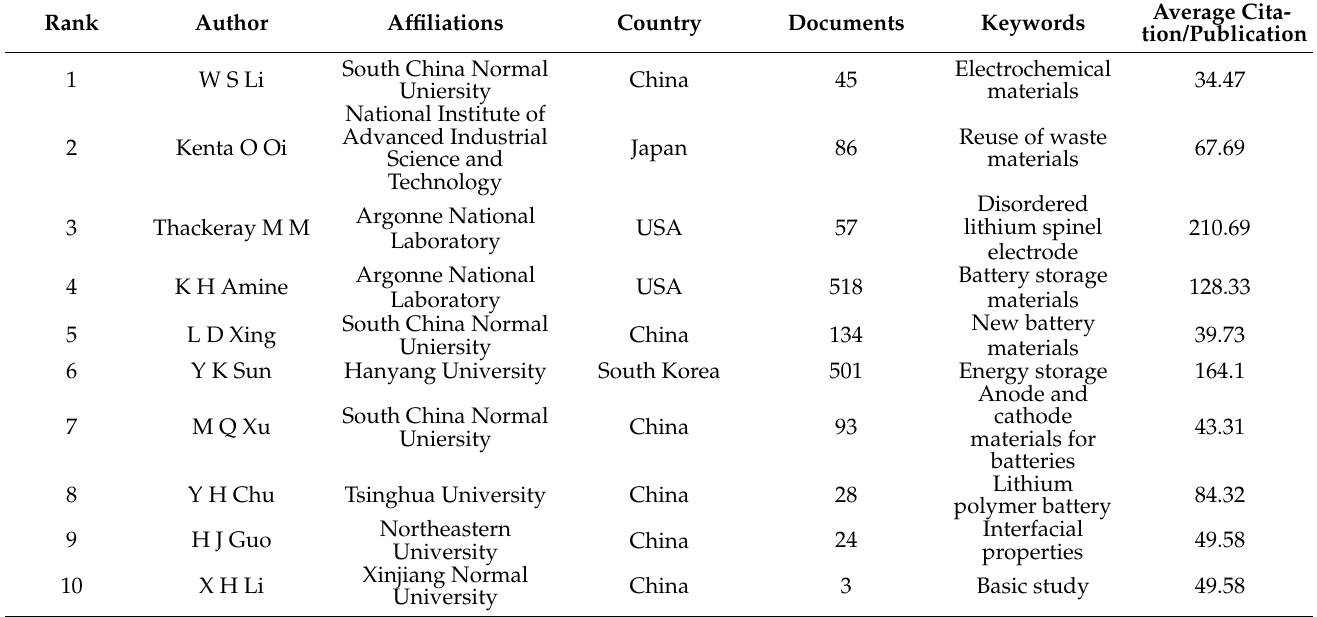
Table 3. Top 10 authors of articles on waste lithium-ion battery